Question: Produce a descriptive caption suitable for publication.
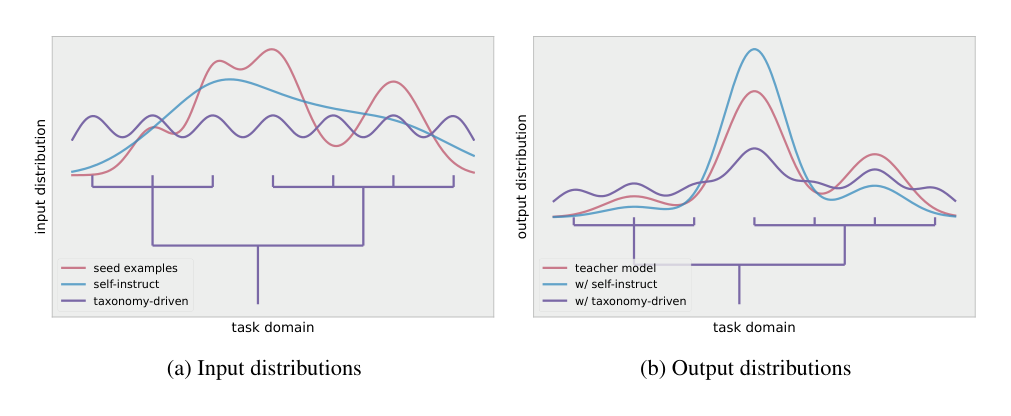
Answer: Intuition of how taxonomy-driven sampling produces diverse set of synthetic data and hence improve the data used to train student model across the task domain. Figure 2a shows how taxonomy-driven sampling leads to an input distribution with wide support and distinct modes while self-instruct gives an smooth input distribution. Figure 2b shows the consequence using inputs in generating synthetic data: teacher model will focus its own dominant modes if the input is smooth but focus on each task better if the inputs are also concentrated on each task.